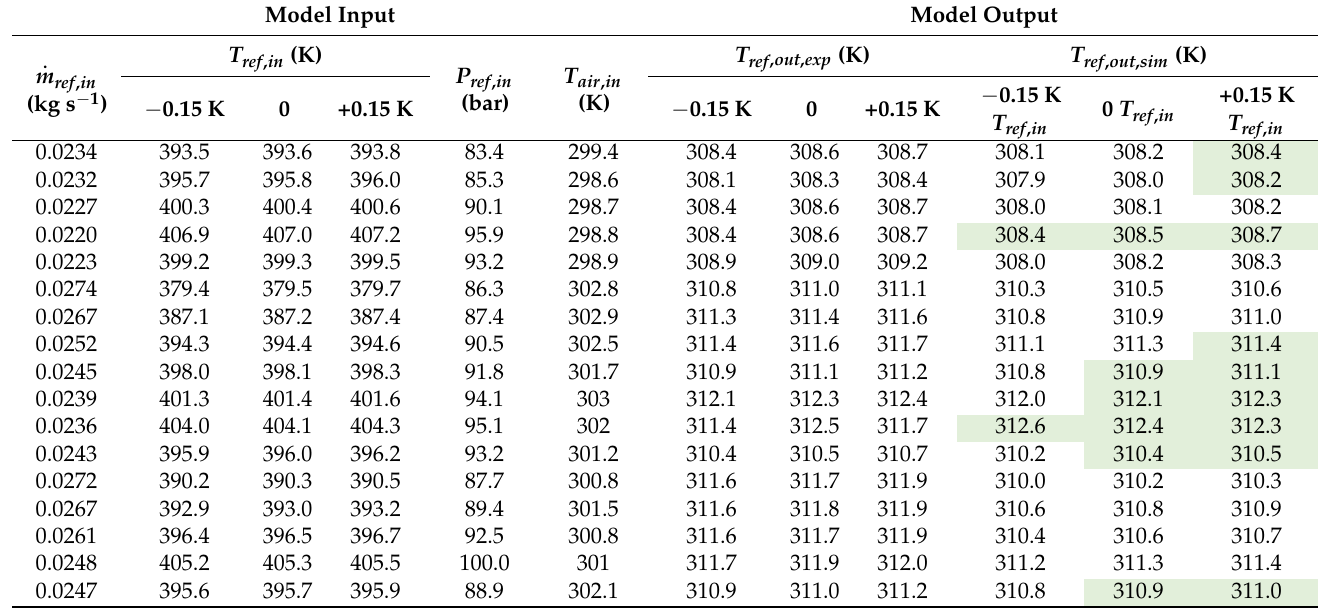
Table 2. Effect of the inlet temperature variation of the refrigerant due to the accuracy of the temperature sensors on the predicted outlet temperature of the refrigerant. The actual measured value is considered for the other inputs. The simulated values within the range of error of the temperature sensor are highlighted with a green background.